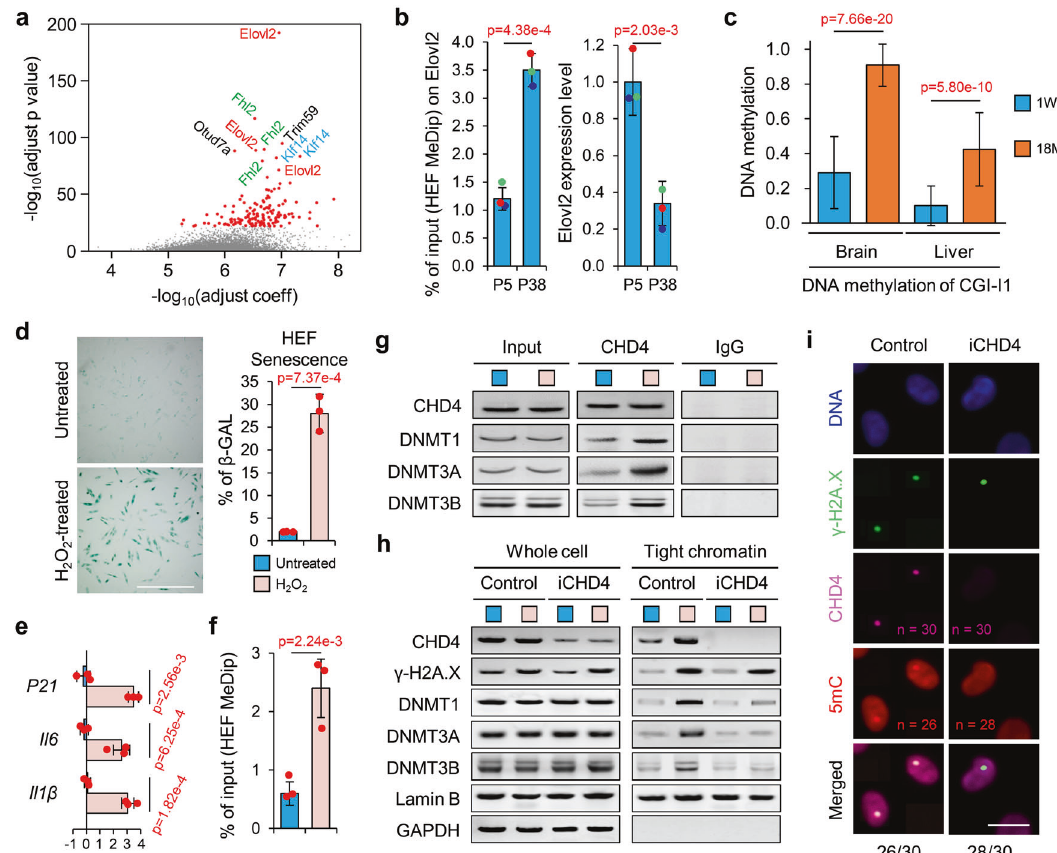
Fig. 1 Elovl2 is a metabolic gene that serves as marker of aging. a Correlation between DNA methylation of genes and aging. The signi fi cant sites are marked. The aging model were described in our previous work. 11 p values are based on a least-squares model built with the same terms and drop-one F tests. b MeDip-qPCR and qPCR of Elovl2 in human fi broblasts ( n = 3). Error bars, standard error of the mean (SEM). Levels of signi fi cance were calculated with one-tailed Student ’ s t test. The expression and DNA methylation based on the same plates of cells, which are inked with the same color. c DNA methylation level on the CpG island in intron 1 (CGI-I1) of Elovl2 in the brain and liver of 129/sv mice. For each group 30 Sanger sequencing results from six mice were used. Error bars, SEM. Levels of signi fi cance were calculated with two- tailed Student ’ s t test. d Beta-galactosidase ( β -GAL) staining on young (p5) human fi broblasts with or without hydrogen peroxide (H 2 O 2 ) treatment ( n = 3). Scale bar, 100 µm. Levels of signi fi cance were calculated with one-tailed Student ’ s t test. e qPCR showing the transcriptional changes of cellular senescence markers in normal and H 2 O 2 treated human fi broblasts ( n = 3). Error bars, SEM. Levels of signi fi cance were calculated with two-tailed Student ’ s t test. f MeDip-qPCR of Elovl2 in H 2 O 2 treated human fi broblasts ( n = 3). Error bars. Levels of signi fi cance were calculated with one-tailed Student ’ s t test. g Co-immunoprecipitation on human fi broblasts with or without H 2 O 2 treatment. h Western blotting showing that the H 2 O 2 -induced accumulation of DNMTs to the chromatins was CHD4-dependent. i The recruitment of CHD4 and 5mC on DNA damage sites of cells irradiated with a 450 nm laser. Scale bar, 5 µm. For each group, 30 cells were treated. 26 out of 30 cells in control group show co-localization of CDH4 and 5mC to γ -H2A.X site, while 28 out of 30 cells in iCDH4 group have no accumulation of CDH4 and 5mC to γ -H2A.X